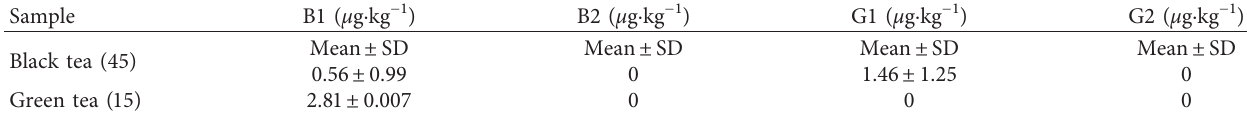
Table 3: Types of aflatoxins in green and black tea.